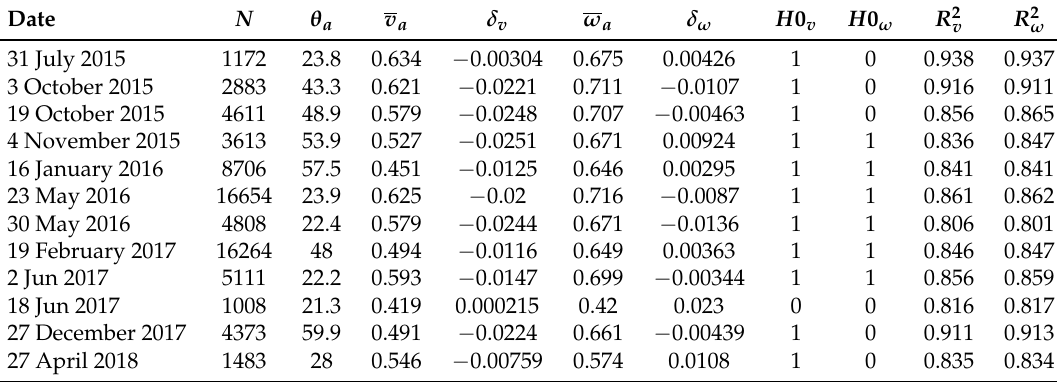
Table 8. Summary of the statistical analyses showing agreement between the AHI and MODIS NDVIs as well as between the AHI and MODIS NDVI-based indices over the Kyushu region. N is the number of pixels sampled on each date. θ a is the AHI solar zenith angle averaged over the area for each